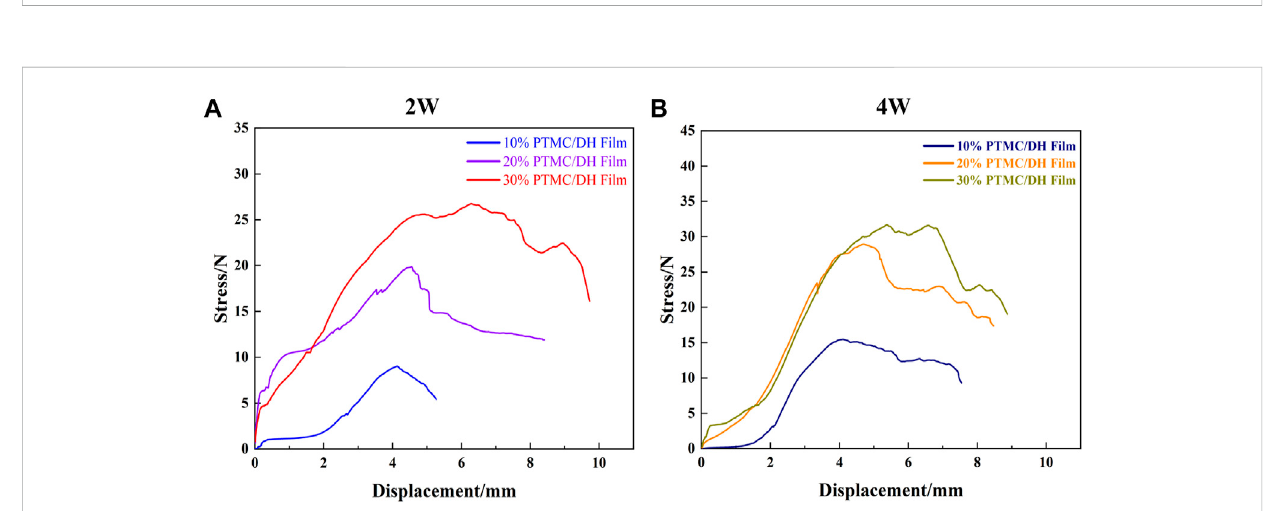
FIGURE 9 Stress-strain curves of the Achilles tendon after stretching at (A) 2 W and (B) 4 W for 10%, 20% and 30% drug-loaded fi